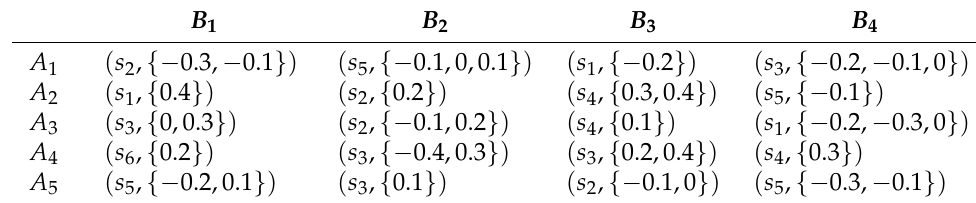
Table 2. The decision matrix M ( 2 ) .